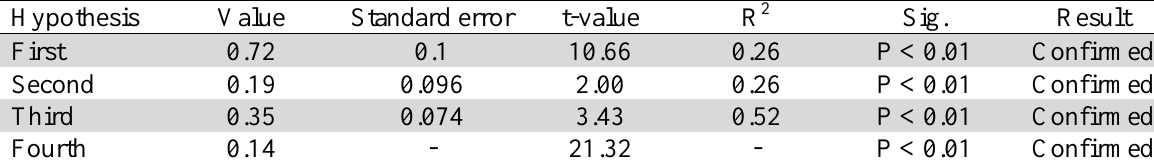
The summary of testing four